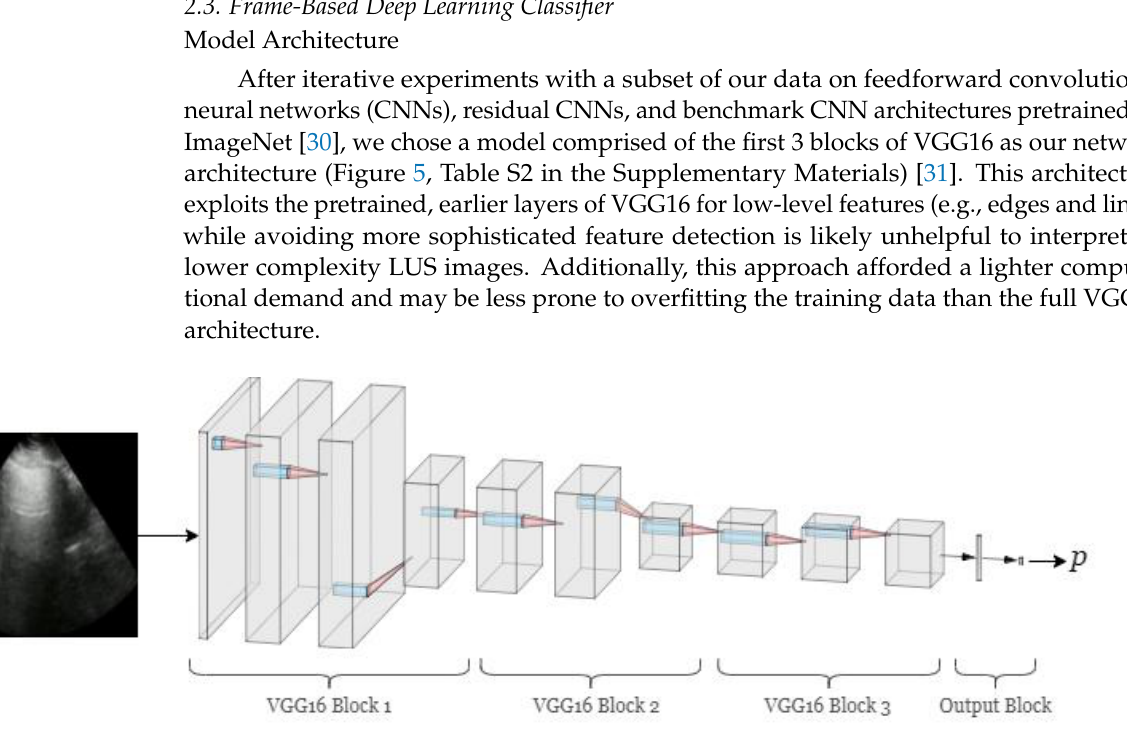
block is removed from our model. The output block consists of a global average pooling layer, followed by dropout and a